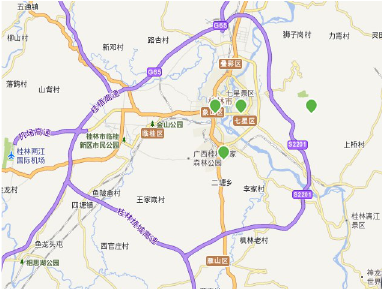
Fig.1 Distribution of Guilin Air Monitoring